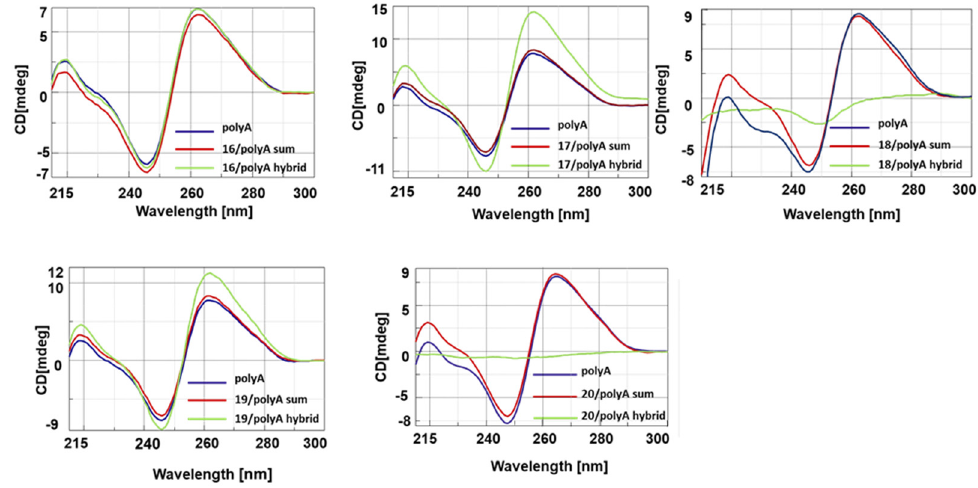
Figure 2. CD spectra of 16 - 20 /PolyA hybrids.